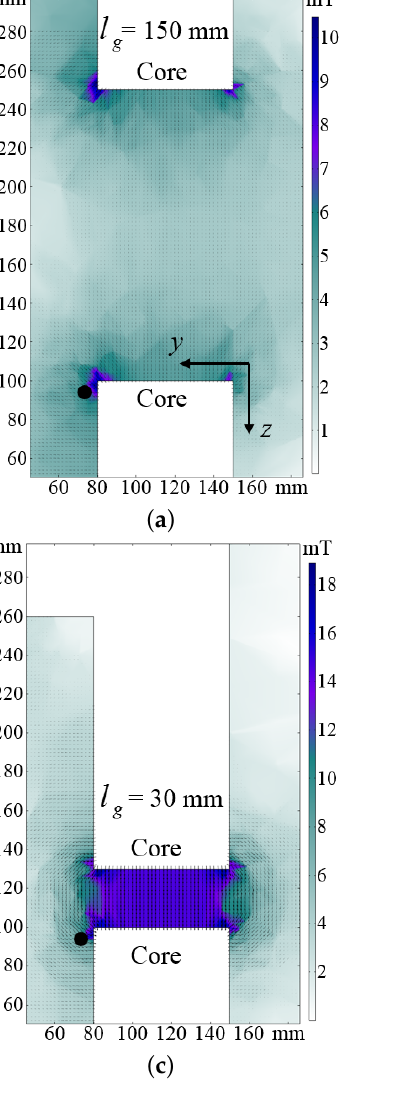
Figure 5. Leakage magnetic flux density distribution in the air gap region for distance ( a ) 150 mm,